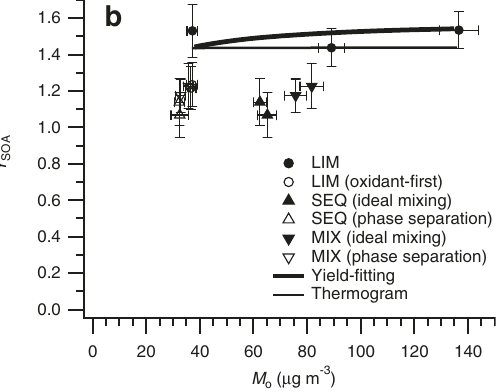
Fig.1|Secondaryorganicaerosol(SOA)massyield( Y SOA )vs.organicmass( M o ). M α -pinene+NO · system from pure α -pinene (APN), Y SOA as a function of o for a 3 sequential oxidation (SEQ), simultaneous oxidation (MIX) experiments and for b limonene+NO 3 · system from pure limonene (LIM), SEQ, and MIX experiments. LIM (oxidant- fi rst) refers to the experiment where N 2 O 5 was fi rst injected into the chamber and followed by the injection of limonene, resembling the limonene oxidationconditionintheSEQexperiment.Idealmixingreferstotheassumptionof the condition where α -pinene and limonene SOA are ideally mixed (thus M o is